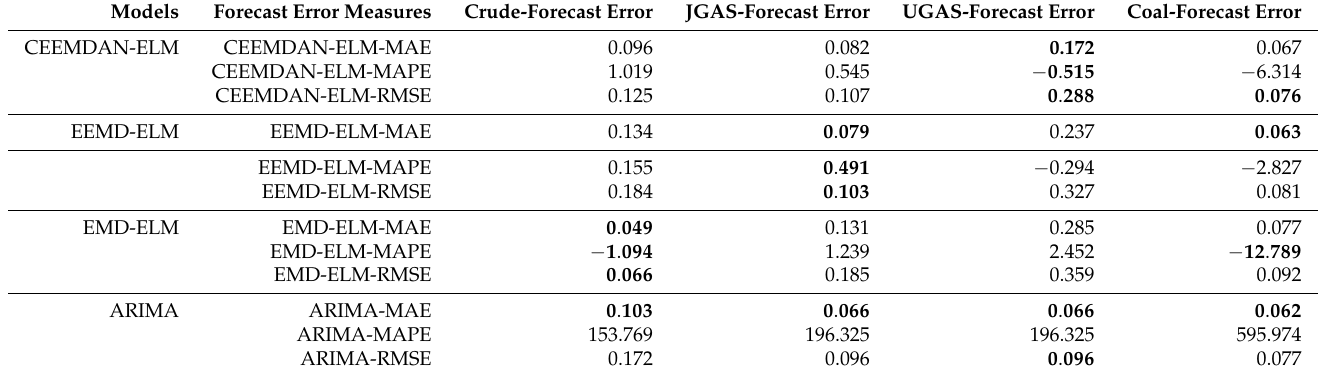
Table 4. Forecasting measures based on MAE, MAPE and RMSE for pre-COVID-19 era. We indicate the minimum forecast error estimates in bold. The minimums are deduced with and without the benchmark, hence this distinction is necessary in order to observe the minimum when comparing the models.